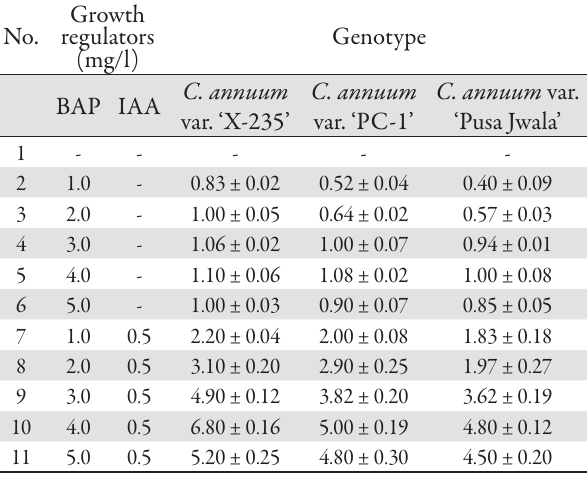
Tab. 1. Effect of BAP and IAA on shoot bud induction from hypocotyl explants of three genotypes of C. annuum L.